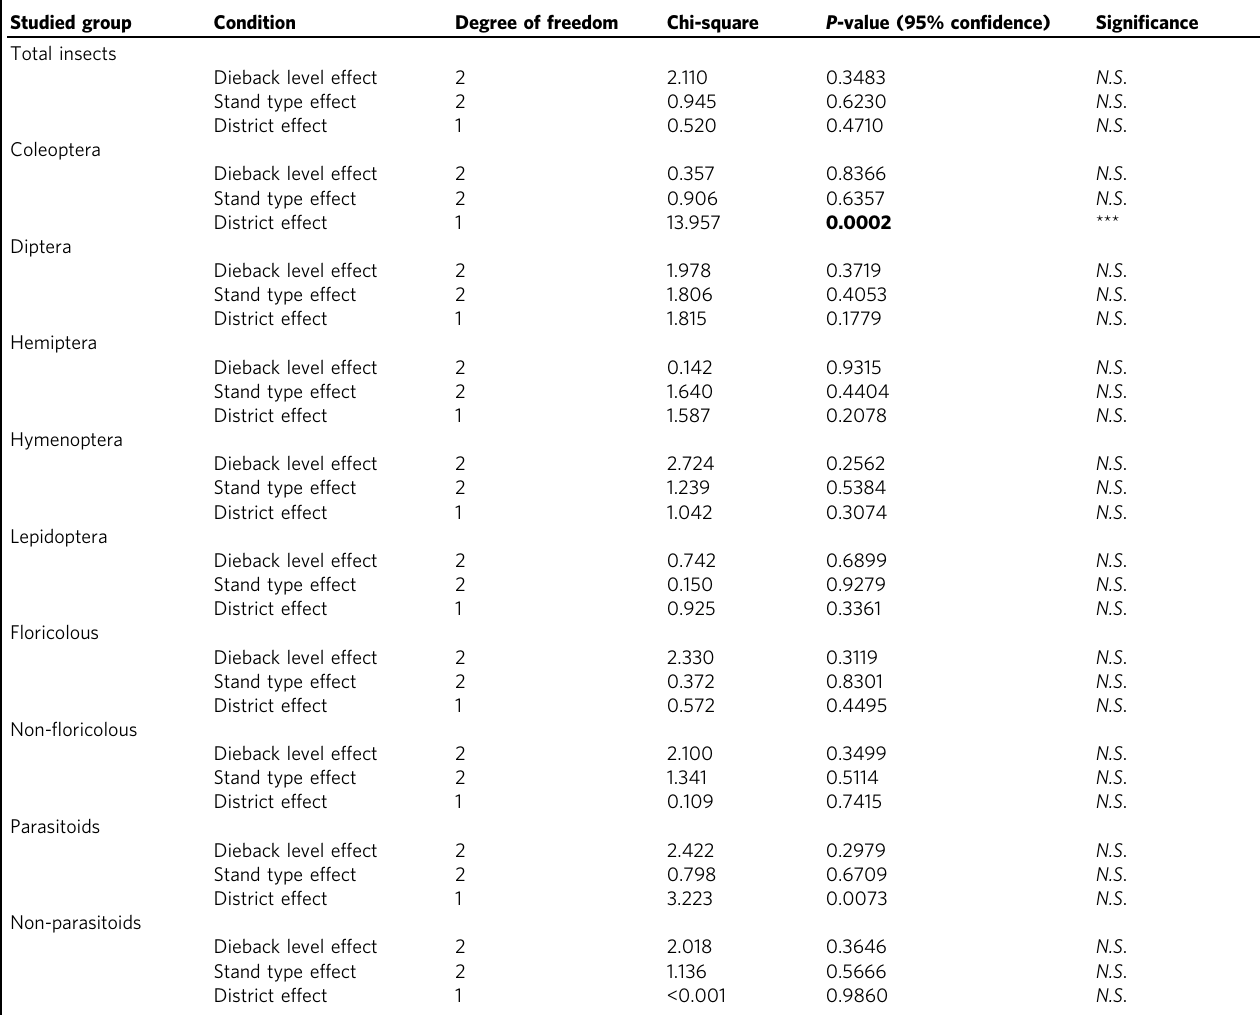
Table 1 Impact of forest dieback and salvage logging on insect species richness. Studied